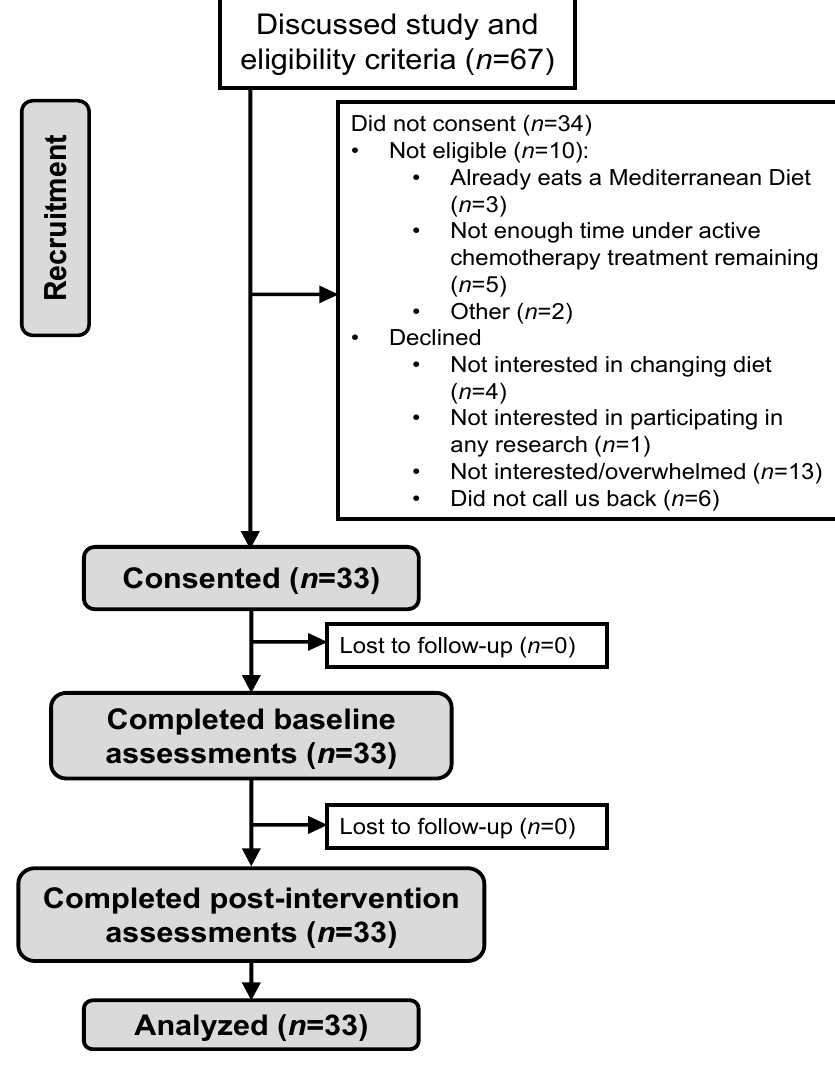
Figure 1. CONSORT diagram.